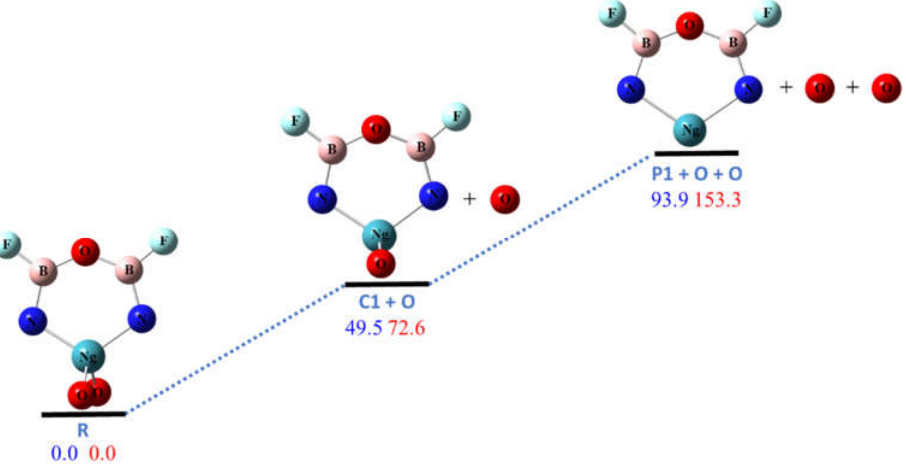
Figure 2. The calculated potential energy (in kcal/mol) profile for the dissociation pathway R1 at CCSD(T)/aptz//B3LYP/aptz level. The values in blue are for Ng = Kr and values in red are for Ng = Xe. The oxygen atoms are assumed to be in singlet state.